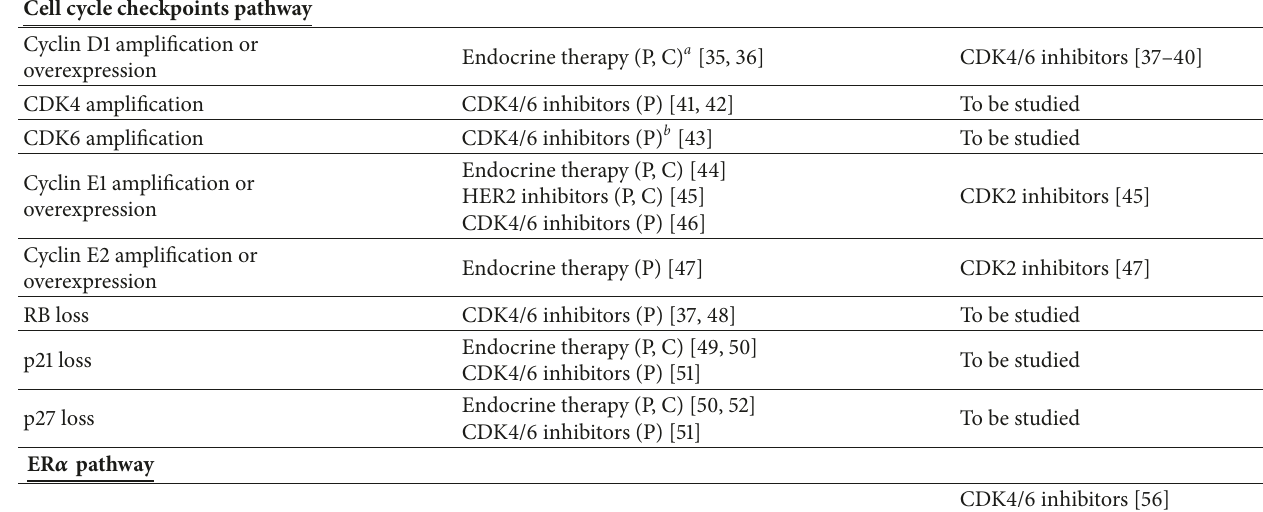
Table 3: Potential pathways of resistance to antihormonal agents, HER2 inhibitors and CDK4/6 inhibitors.